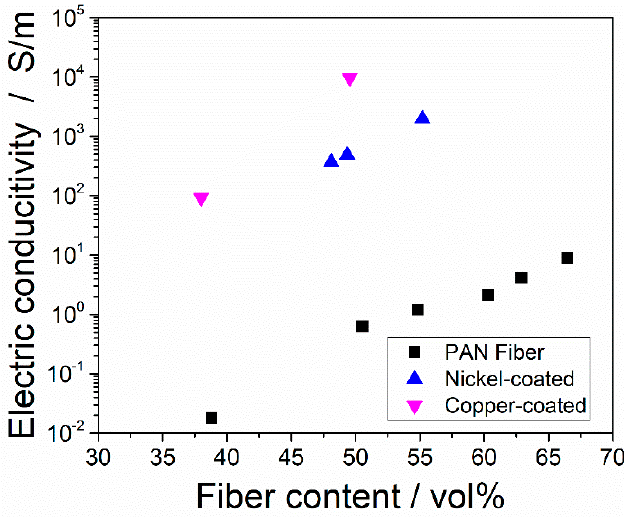
Figure 9. Electric conductivity of uncoated and metal-coated laminates.